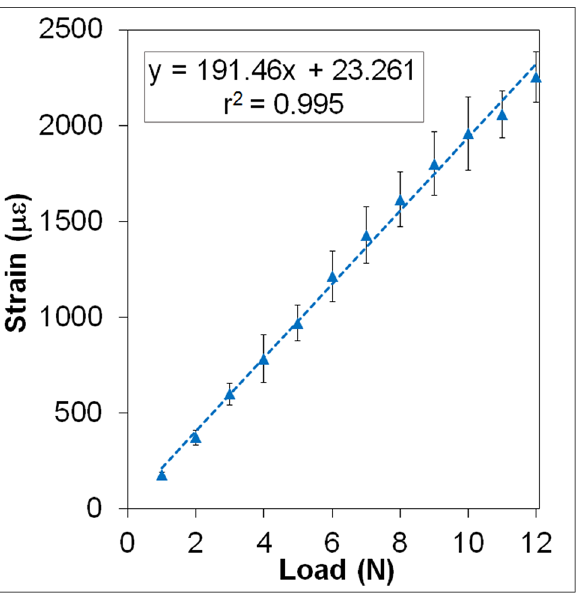
Fig 1. Load/Strain Calibration Curve. This figure demonstrates the linear relationship between applied load and resulting tensile strain at the periosteal mid-diaphysis. For all data points, error bars represent the standard deviation from n = 5